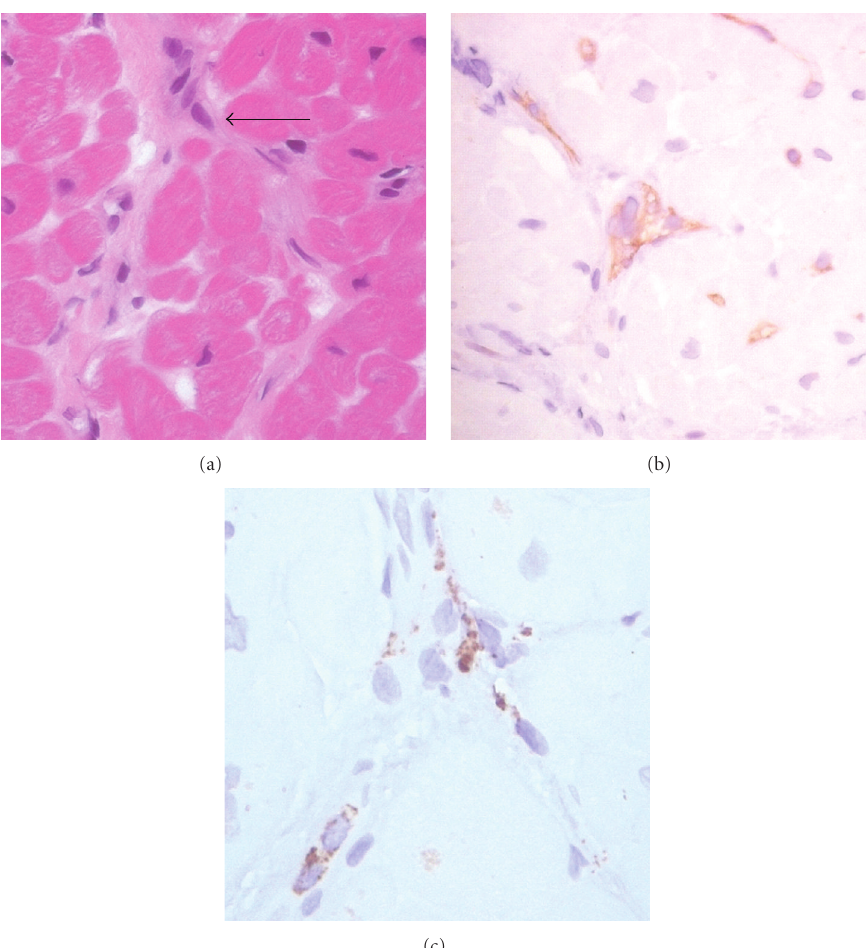
Figure 1: Histopathologic and immunopathologic biopsy features of AMR. (a) A biopsy sample stained with hematoxylin and eosin shows evidence of endothelial cell swelling (arrow). (b) An immunoperoxidase stain shows di ff use C4d deposition in capillaries. (c) An immunoperoxidase stain confirms the presence of intravascular macrophages with positive staining for